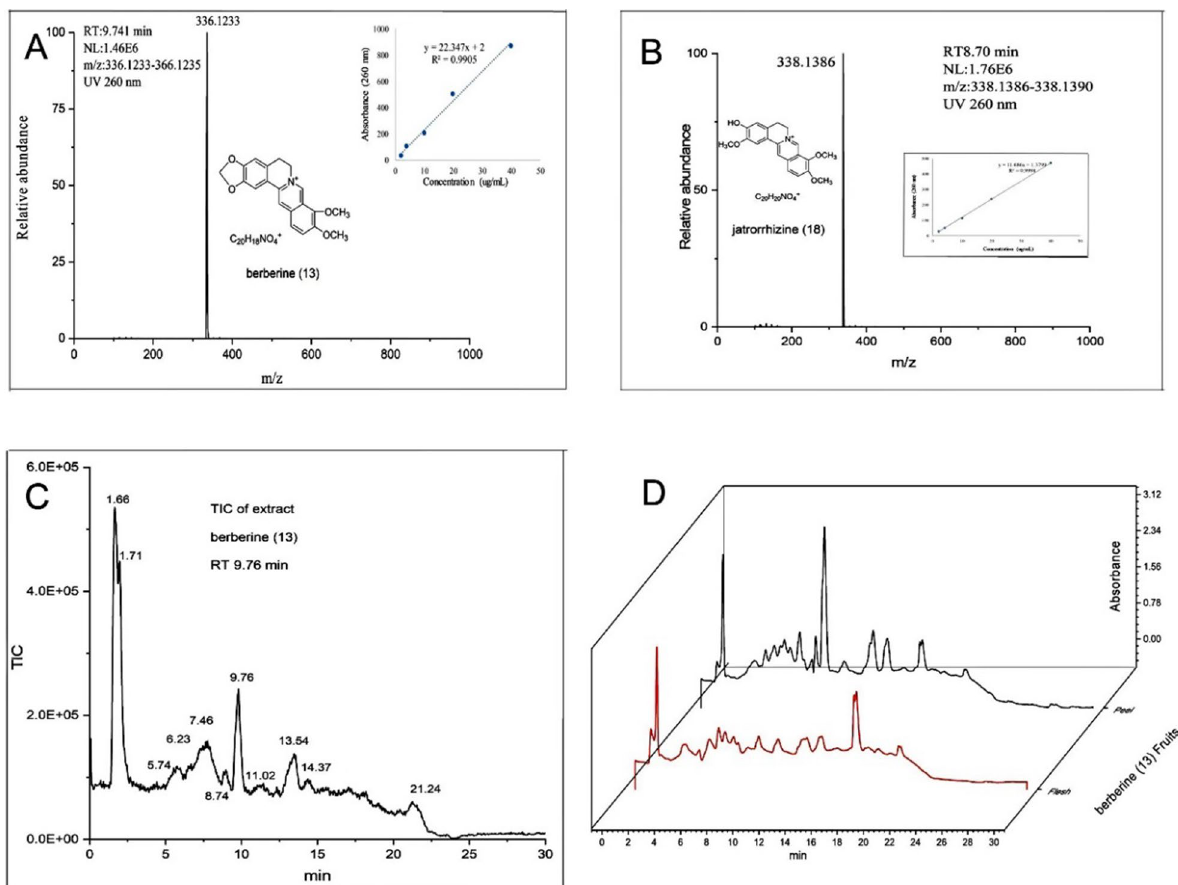
Fig. 6 UHPLC/ESI Q‑Orbitrap MS chromatograms and spectra: qualitative compounds by LC–MS characteristics berberine ( A ); jatrorrhizine ( B ); total